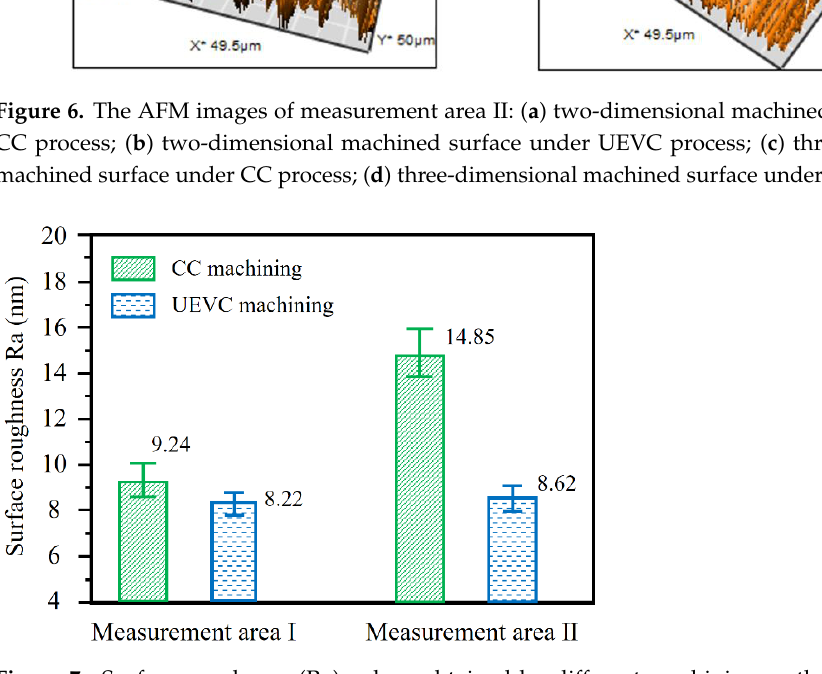
Figure 7. Surface roughness (Ra) values obtained by different machining methods in different meas- urement areas. measurement